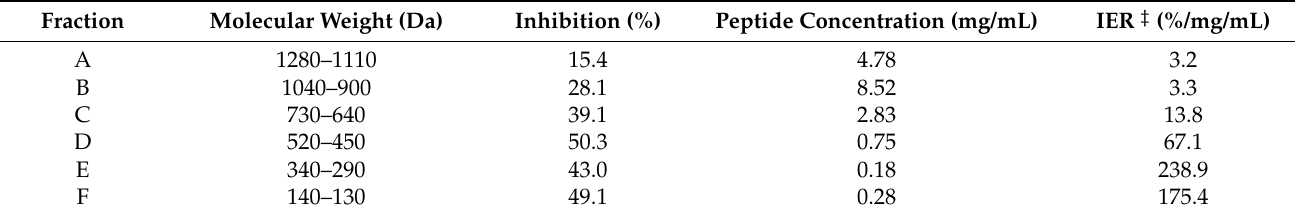
Figure 1. Sephadex G-25 column chromatography of peptides separated from F-HHP + PN-6 + PP. ● (Standard materials) 1, Bacitracin (1422.7 Da); 2, Glycine-Glycine-Tyrosine-Arginine (451.5 Da); 3, Tryptophan (204.2 Da). F-HHP + PN-6 + PP: lactic fermented seabass byproduct hydrolysates produced by Protease N under HHP for 6 h and then rehydrolysis with gastrointestinal proteases. (A–F: numbers of fractions). Table 4. The inhibition against cholesterol micelle formation of the size exclusion chromatographic fractions obtained from F-HHP + PN-6 + PP † .